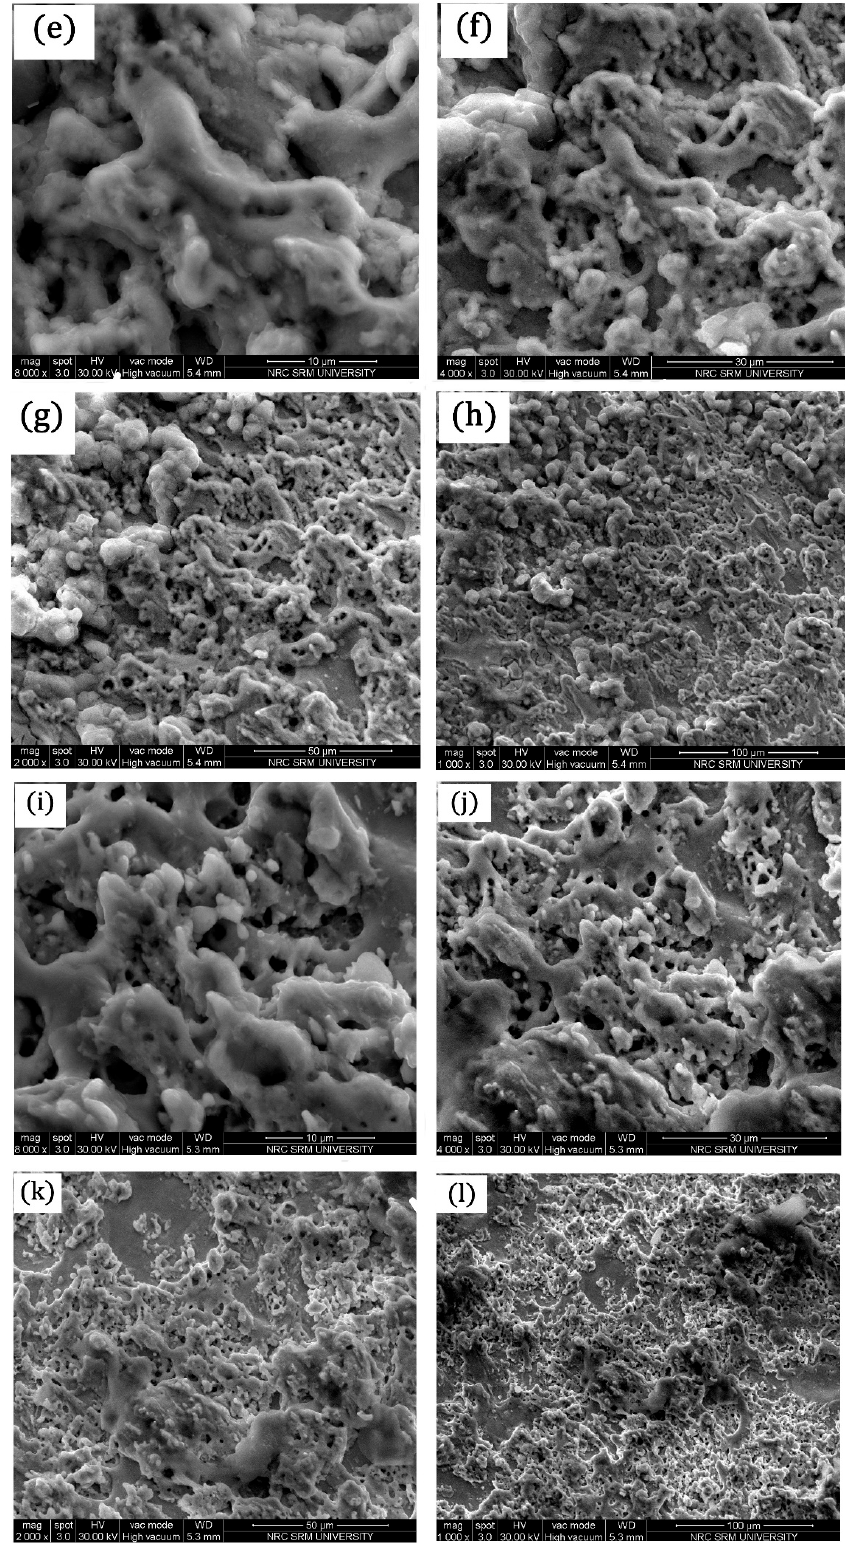
Figure 16. Scanning electron microscopic image analysis of the friction surfacing of AISI316 over EN8 alloy ( a – d ) interface region, ( e – h ) mechtrode surface, and ( i – l ) substrate